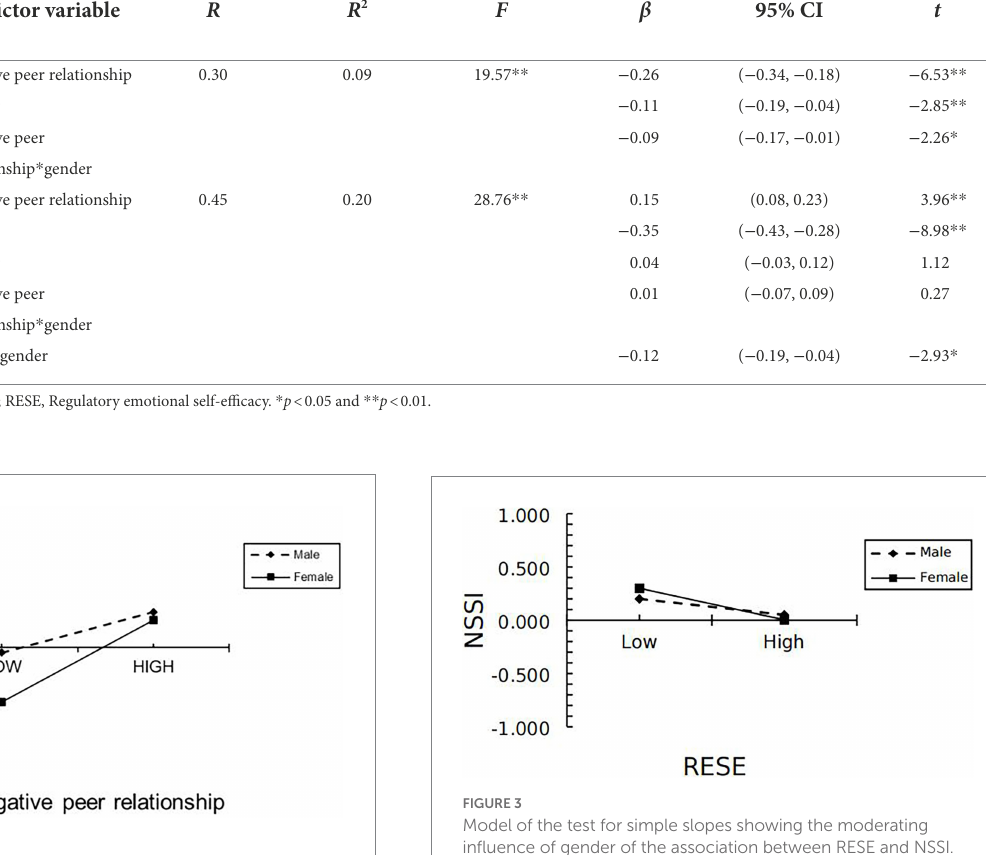
FIGURE 2 Model of the test for simple slopes showing the moderating influence of gender of the association between negative peer relationship and RESE.